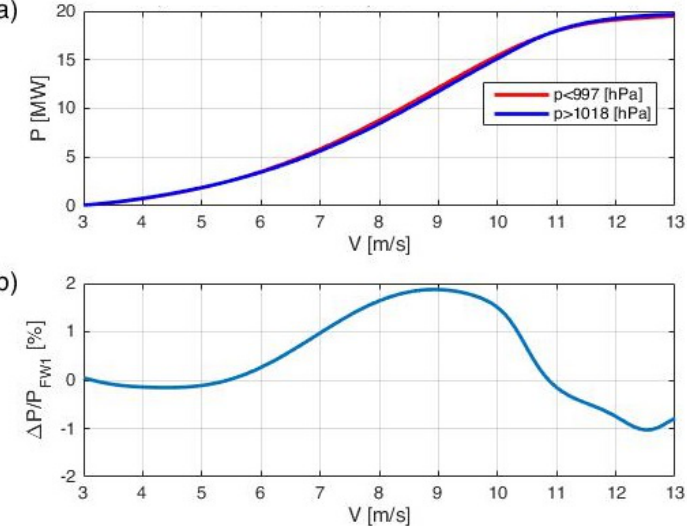
Figure 11. Wind power plant FW1: ( a ) power characteristics for p < 997 hPa and p > 1018 hPa, determined using neural networks, ( b ) power plant power difference for both cases as percentage of the farm’s rated